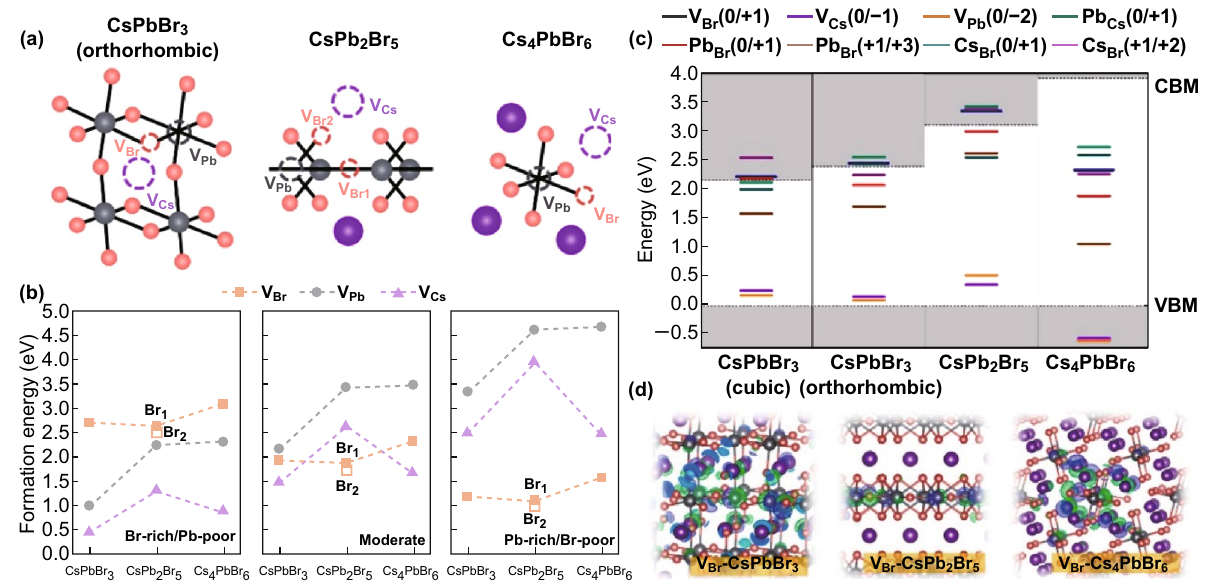
Fig. 10 a Illustrations of Br, Pb and Cs vacancies (VBr, VPb and VCs). b Calculated defect formation energies for orthorhombic-CsPbBr 3 , CsPb 2 Br 5 and Cs 4 PbBr 6 at Br-rich/Pb-poor, moderate and Pb-rich/Br-poor conditions. c Defect charge transition levels of CsPbBr 3 , CsPb 2 Br 5 and Cs 4 PbBr 6 . d Charge density distributions of V Br defect states for CsPbBr 3 , CsPb 2 Br 5 and Cs 4 PbBr 6 calculated at the GGA/PBE level of theory. The band gaps were corrected using the HSE + SOC method. Reprinted with permission from Ref. [26]. Copyright American